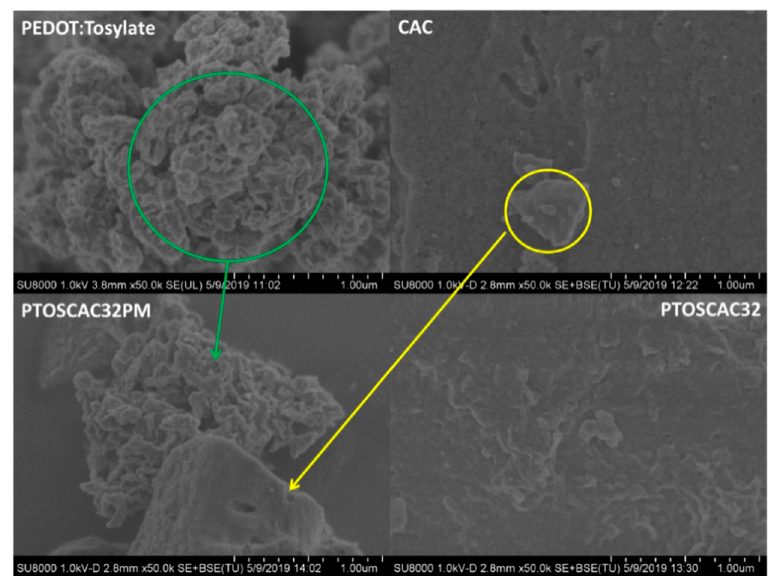
Figure 1. SEM micrographs of PEDOT:Tosylate, CAC, PTOSAC32 and PTOSAC32PM. Micrographs correspond to 50k × magnification.